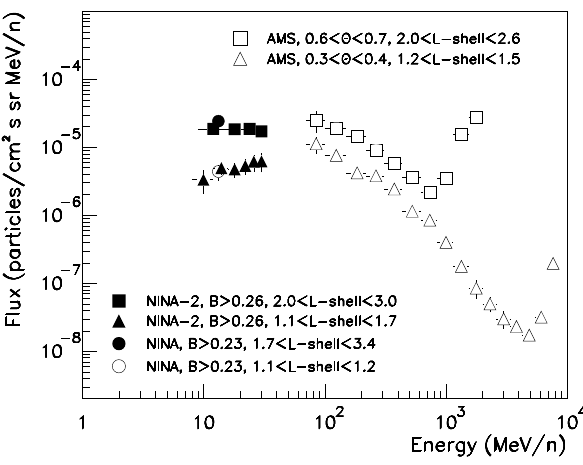
Fig. 2. Differential energy spectra of secondary protons, as mea- sured by NINA and NINA-2, at different L-shell ranges. For com- parison, data from the AMS experiment are also